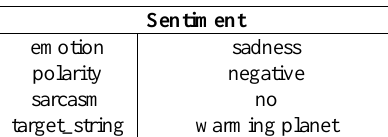
Table 2 . Annotations on a sentence with an extracted sentiment.